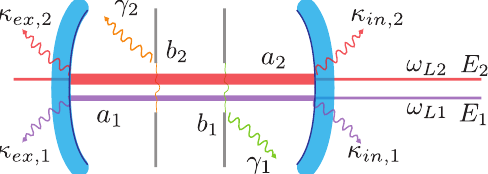
Figure 1. Sketch of the system dynamics. The annihilation operator a i describes the cavity modes. The decay rates through the output and input mirror, κ ex , i and κ in , i , respectively, quantify the optical mode coupling to the environment. The radiation pressure couples the membranes mechanical modes, characterised by operators b j and decay rates γ j , to the optical